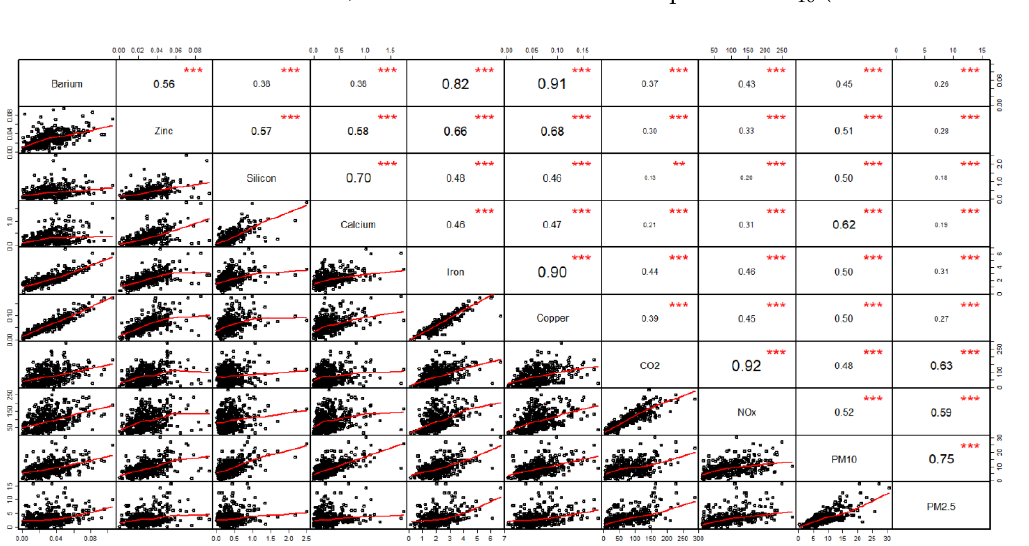
Figure 4. Spearman correlations of the roadside traffic increments (roadside–background) of PM 10 , PM 2.5 ; key elemental trace elements and exhaust gases are shown on the top of diagonal with their associated p -value symbol (*** ≤ 0.001 ; ** ≤ 0.01), whilst the bivariate scatter plots with smoothed monotonic regression curves are displayed on the bottom diagonal. Strong correlations were seen between the traffic increments of PM 10 /PM 2.5 , Ba/Cu/Fe/Zn (brake/tyre/exhaust emissions), Si/Ca (resuspension), and exhaust gas emissions (CO 2 /NO x ).